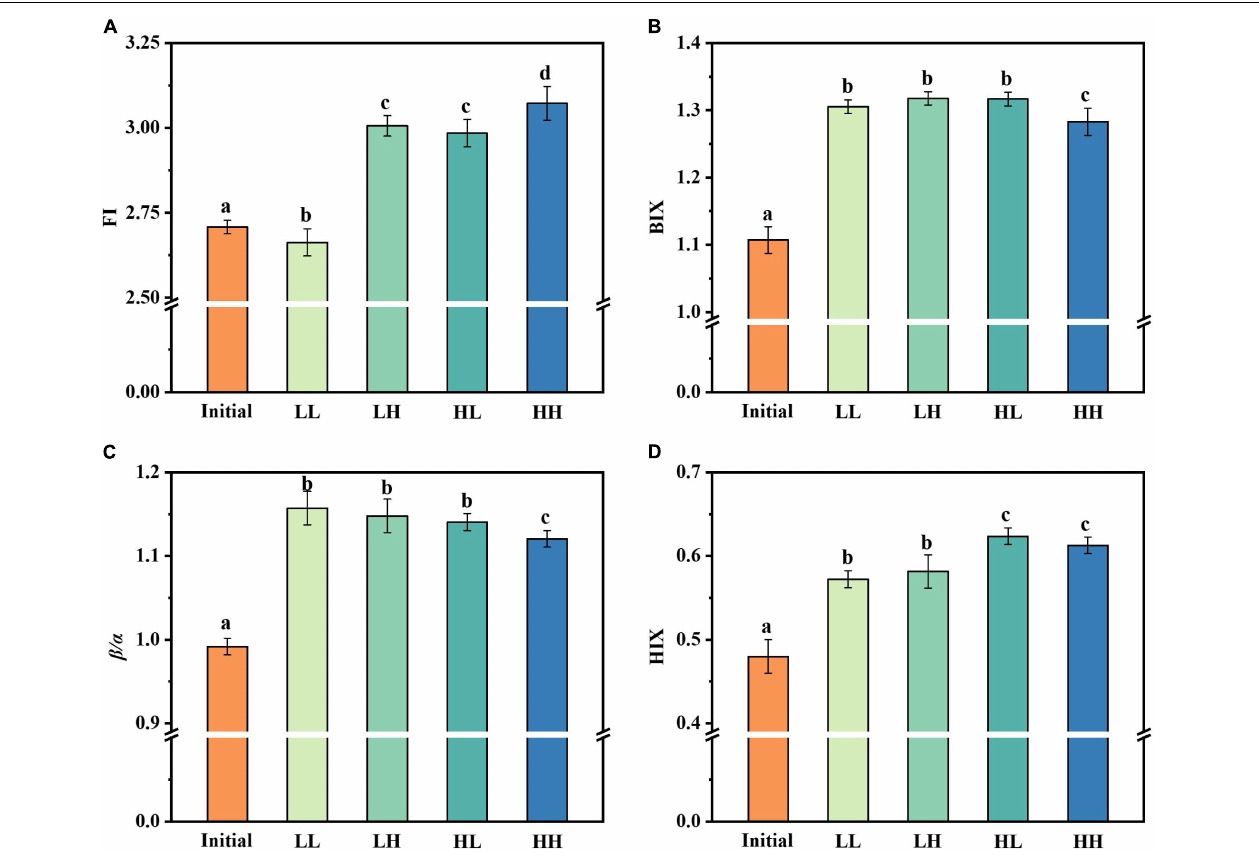
FIGURE 3 | Changes in fluorescence indices under warming and acidification conditions. (A–D) Represent FI, BIX, β / α , and HIX respectively. Initial, initial value; LL, 27 ◦ C and 400 ppm; LH, 27 ◦ C and 1,000 ppm; HL, 31 ◦ C and 400 ppm; HH, 31 ◦ C and 1000 ppm. All data are presented as mean ± SD ( n = 3). Error bars represent the standard error for duplicate cultures. Different letters (e.g., “a,” “b,” “c,” and “d”) represented significant difference ( p < 0.05), as determined by a one-way analysis of variance